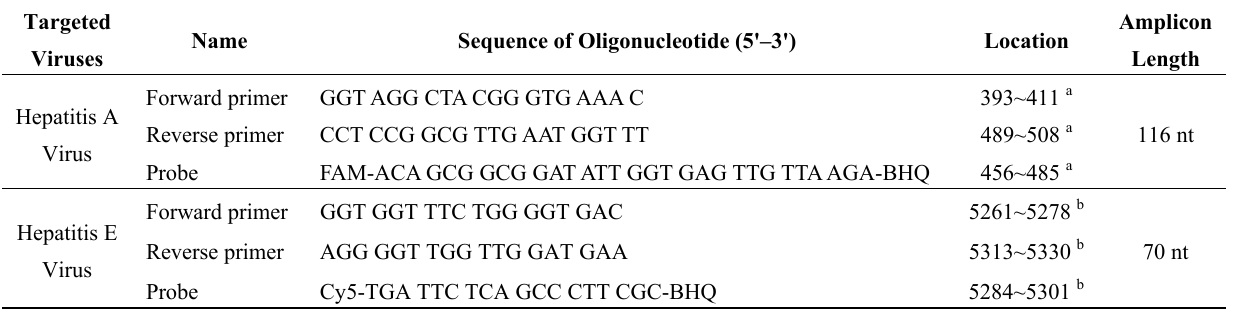
Table 3. Primers and hydrolysis probes used in the